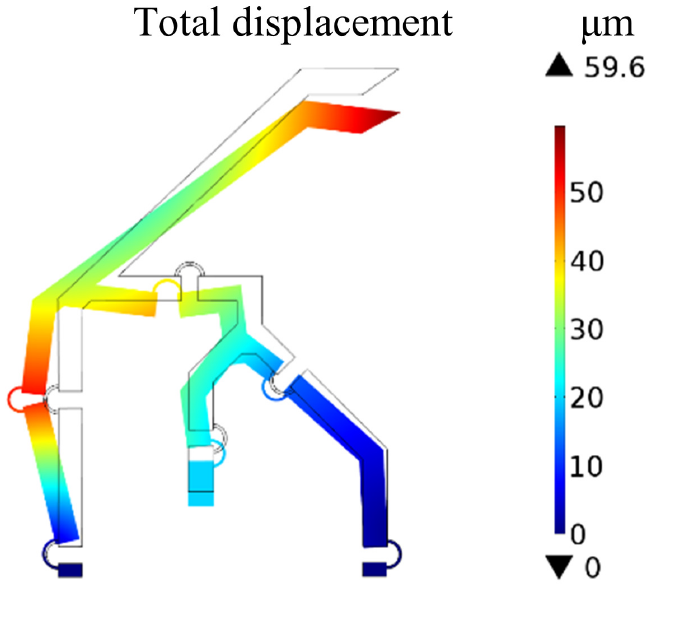
Figure 15. Finite Element Analysis of the compliant structure: neutral configuration (wireframe) and deformed one for ∆ u = − 20 µ